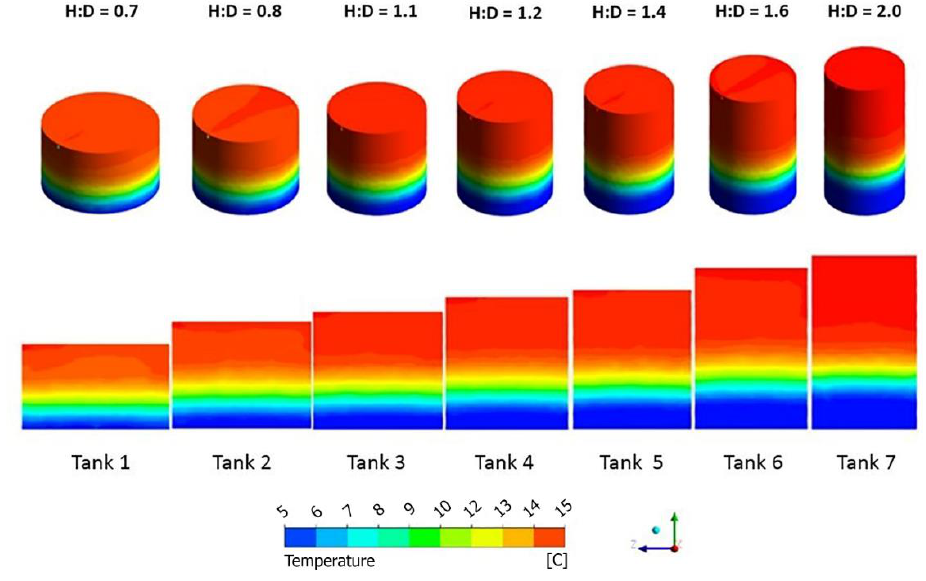
Figure 5. Variations of water temperature inside tanks after 13 h of discharging [69].